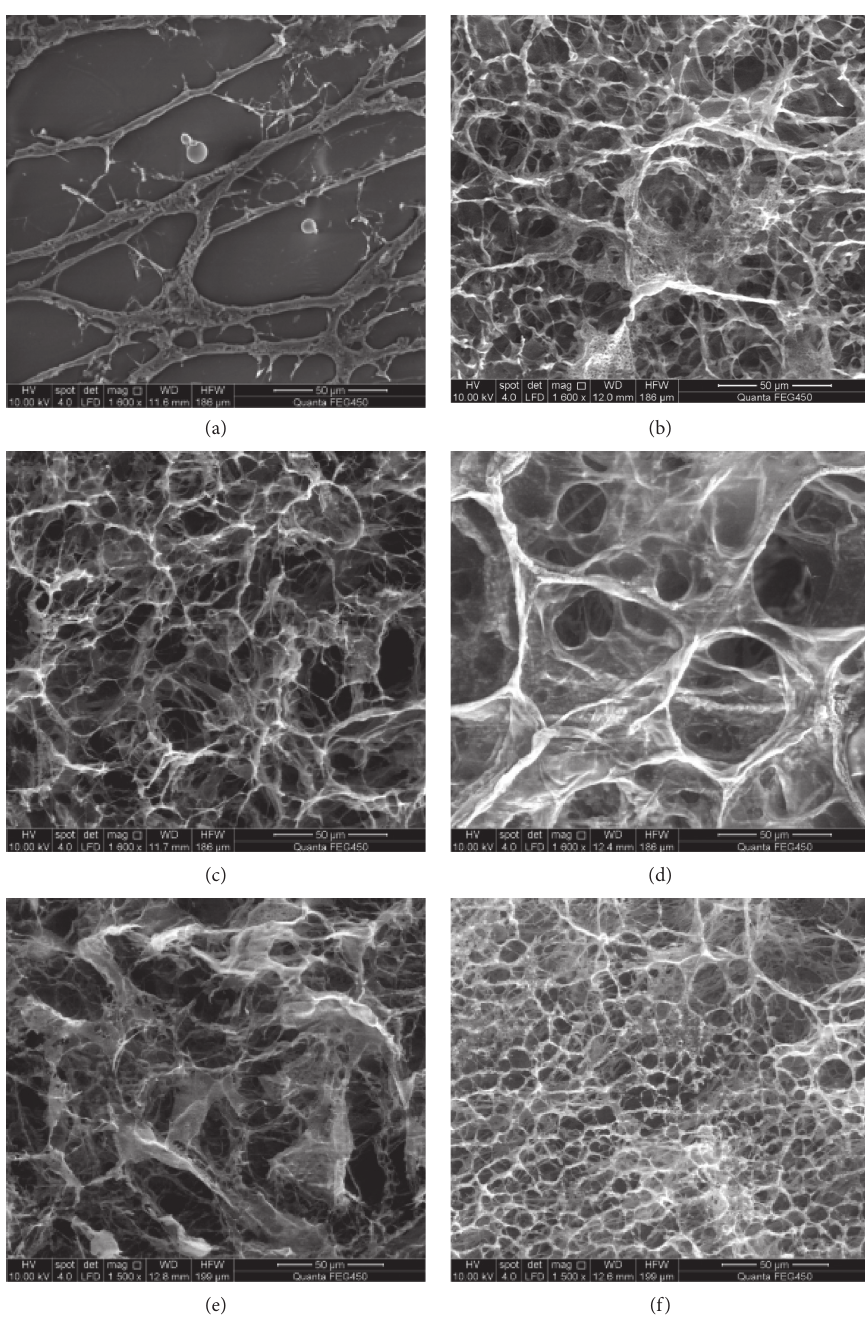
Figure 5: Polymeric microsphere solution after hydration and swelling in simulated formulation water over time. (a) Polymeric mi- crosphere solution before aging in simulated formation water. (b) Polymeric microsphere solution after aging for 1d. (c) Polymeric microsphere solution after aging for 5d. (d) Polymeric microsphere solution after aging for 10d. (e) Polymeric microsphere solution after aging for 15d. (f) Polymeric microsphere solution after aging for